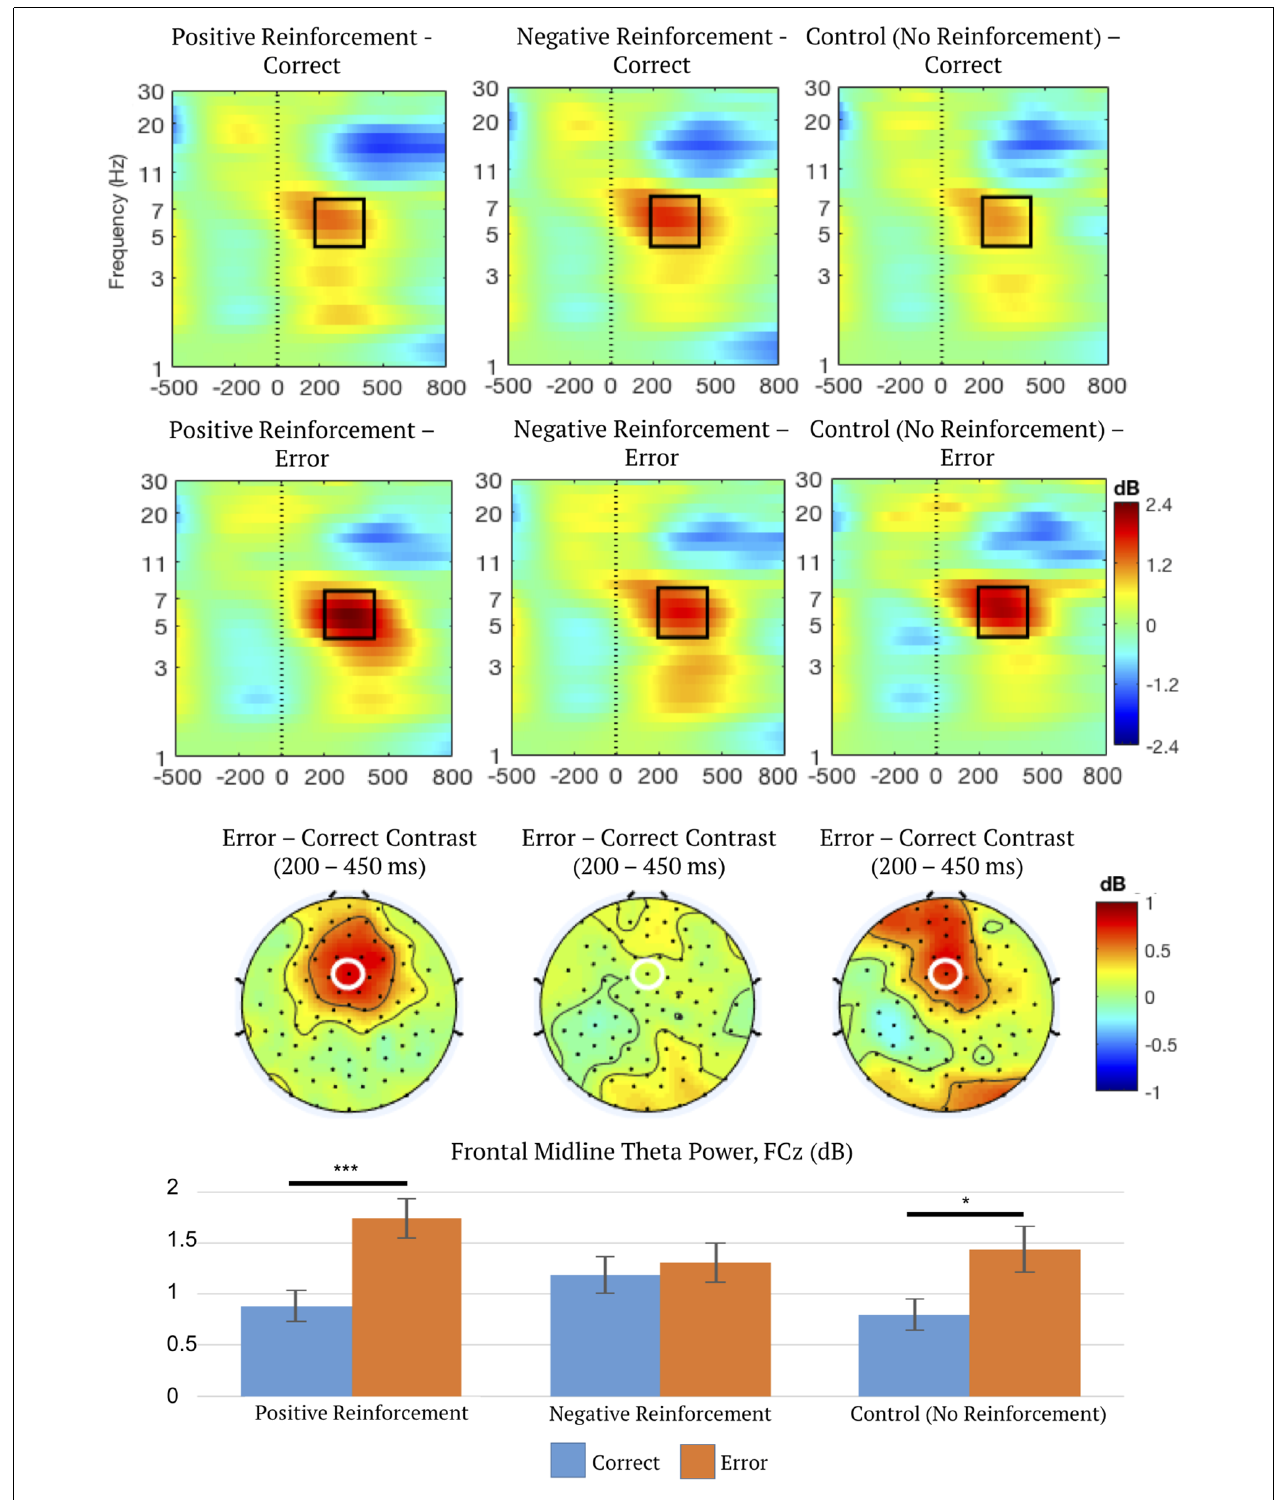
FIGURE 5 | Time-frequency spectrograms measured at FCz (top), topographic distributions of the error-correct difference in frontal midline theta (FM (cid:50) ) time (200–450 ms) and frequency ranges (4–8 Hz; middle), and mean FM (cid:50) power (bottom) depicting the interaction between reinforcement type (positive, negative, or control) and outcome (correct or error). Frequency-specific power is dB-transformed using − 500 to − 200 ms pre-feedback as baseline. FCz is marked by a white ellipse. Black outlines enclose the region of data exported for statistical analysis. Error bars represent 1 ± SEM. ∗ p < 0.05, ∗∗∗ p < 0.001.